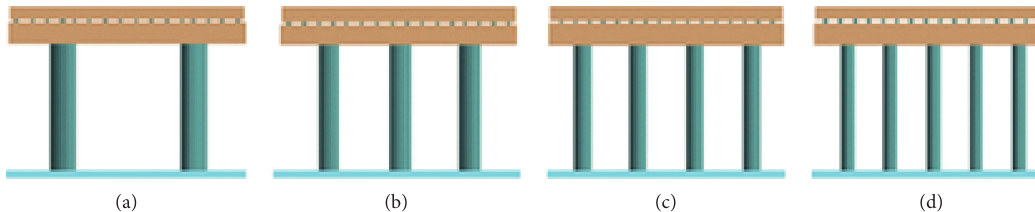
Figure 12: Different multicolumn pier systems: (a) two-column, (b) three-column, (c) four-column, and (d) five-column.